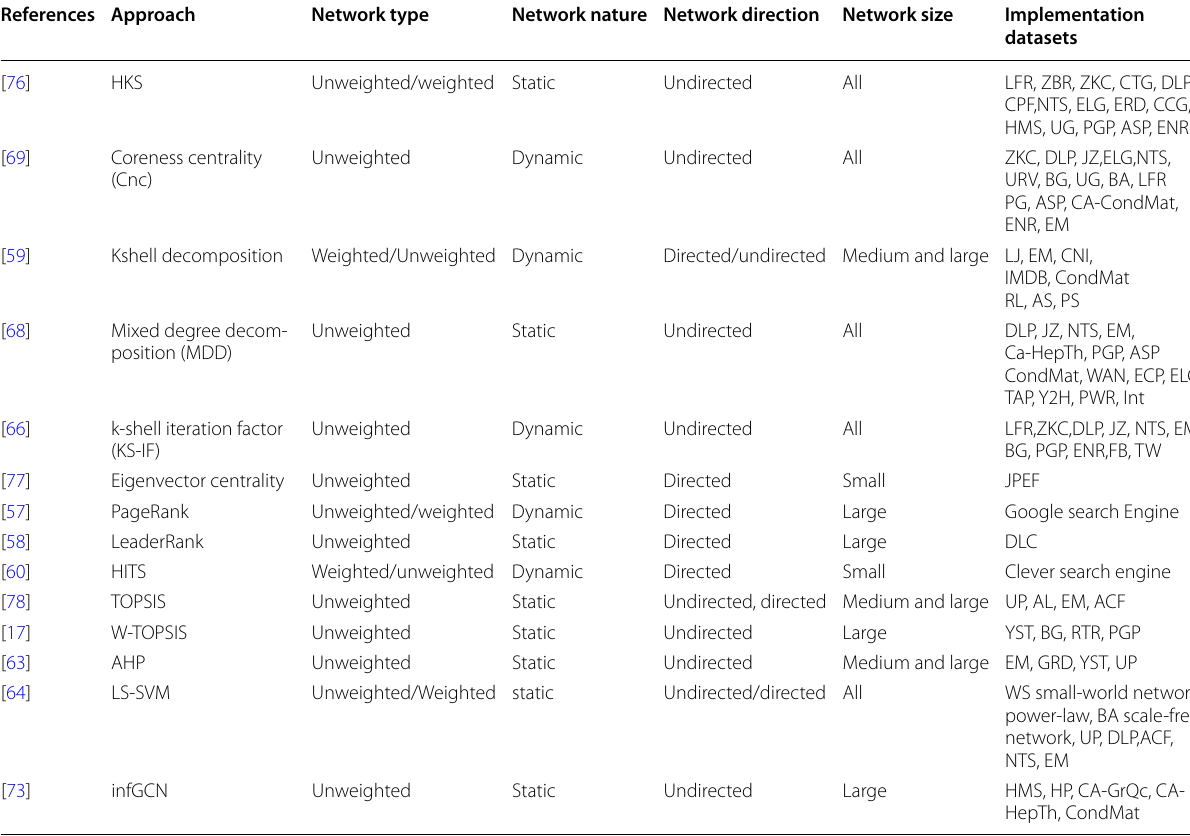
Table 3 Influential nodes finding approaches comparison References